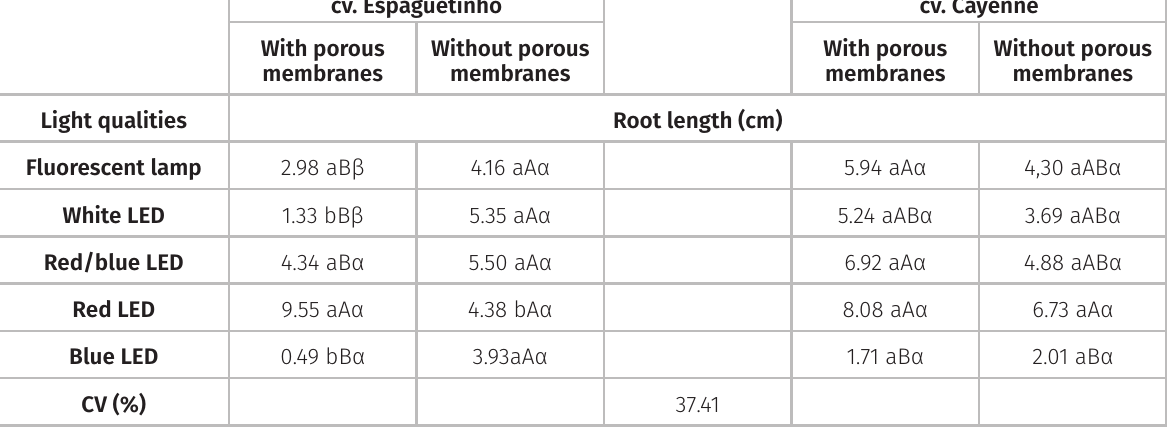
Table I. Root length of Capsicum frutescens cultivars (‘Espaguetinho’ and ‘Cayenne’) cultivated under different light qualities and types of sealing.